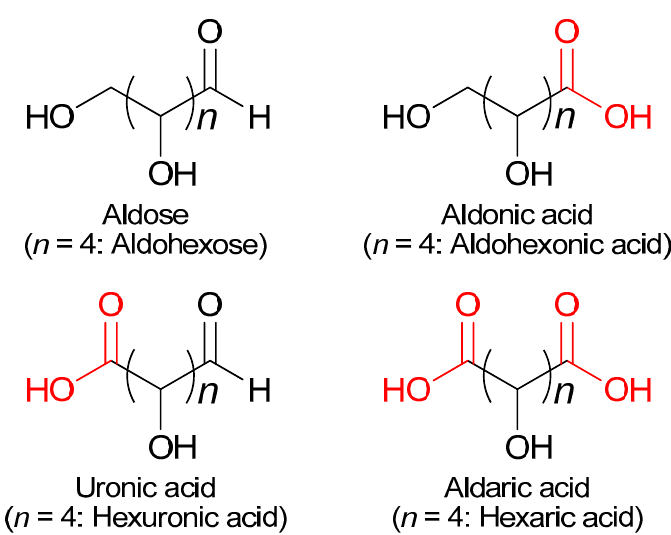
Figure 1. Structures of aldose and its acids.